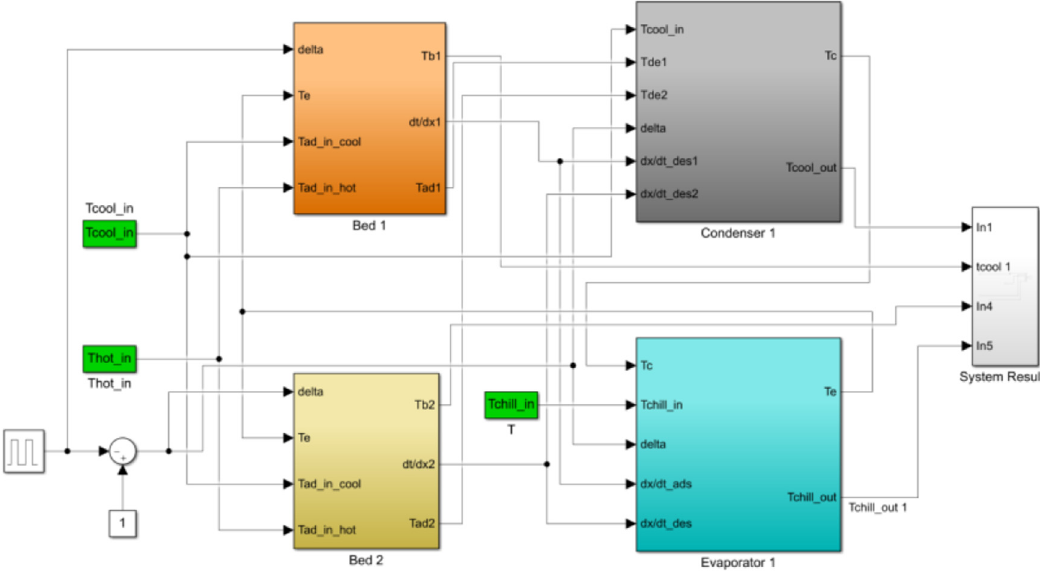
Fig. 3. Simulink view of the system.